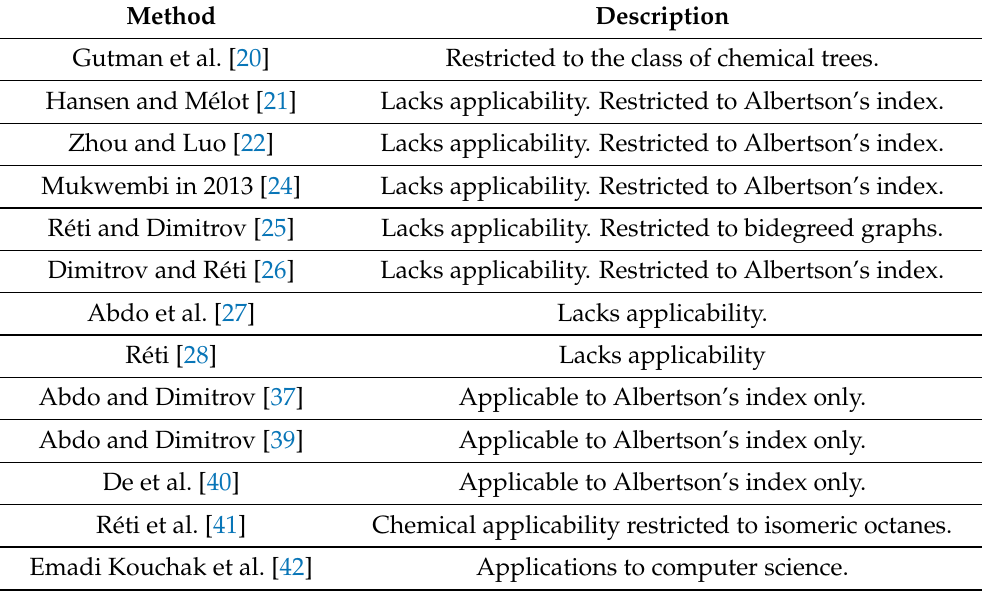
Table 1. Some methods studying irregularity